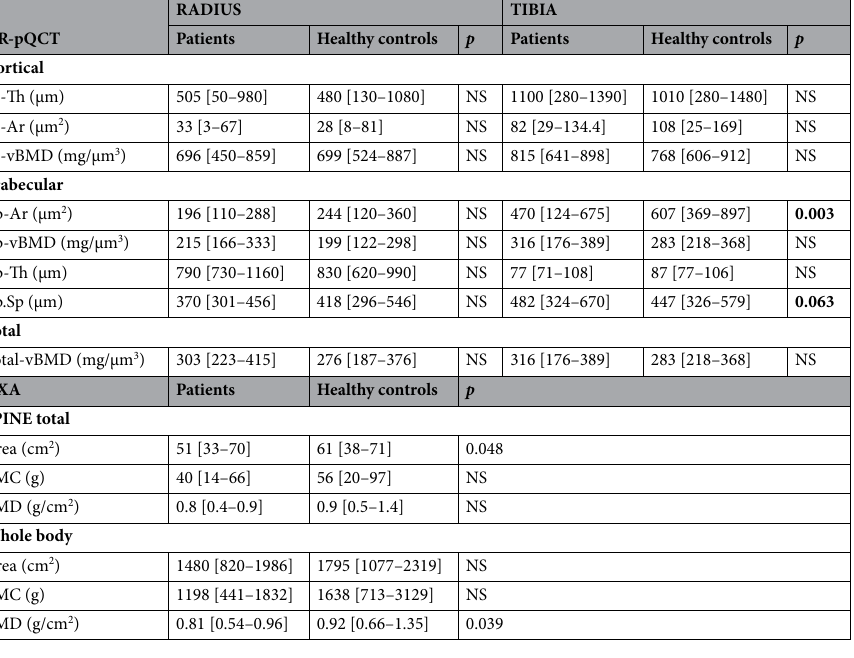
Table 3. HR-pQCT and DXA values between patients and healthy controls. Results as median [min–max], Ar: Area, Ct: cortical, BMC: bone mineral content, BMD: bone mineral density, Ct-Ar: cortical area, HR-pQCT: high resolution peripheral quantitative computed tomography, Tb: trabecular, TbN: trabecular number, TbSp: trabecular separation, TbSpSD: heterogeneity of trabecular separation, TbTh: trabecular thickness, Th: thickness, vBMD: volumetric bone mineral density, p < 0.05 significant. Of note: tota body scan excluded the